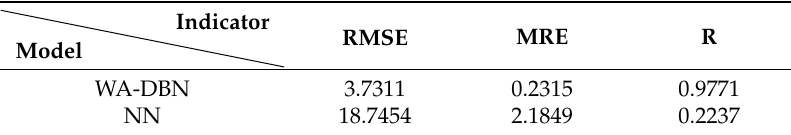
Table 5. Error analysis of WA-DBN and NN.